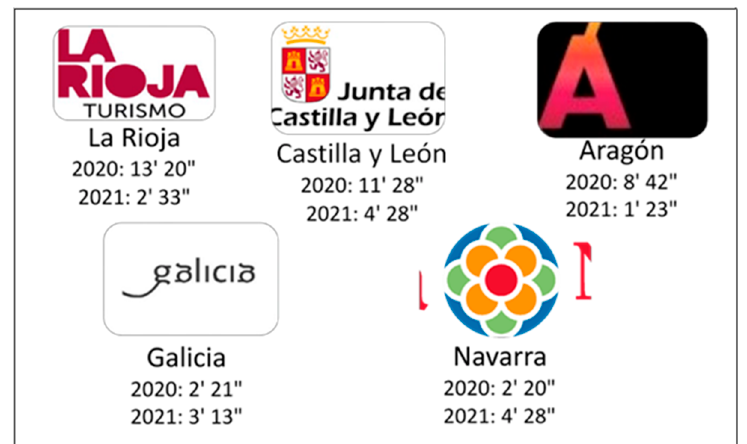
Figure 5. Average duration of visits to the websites analysed .